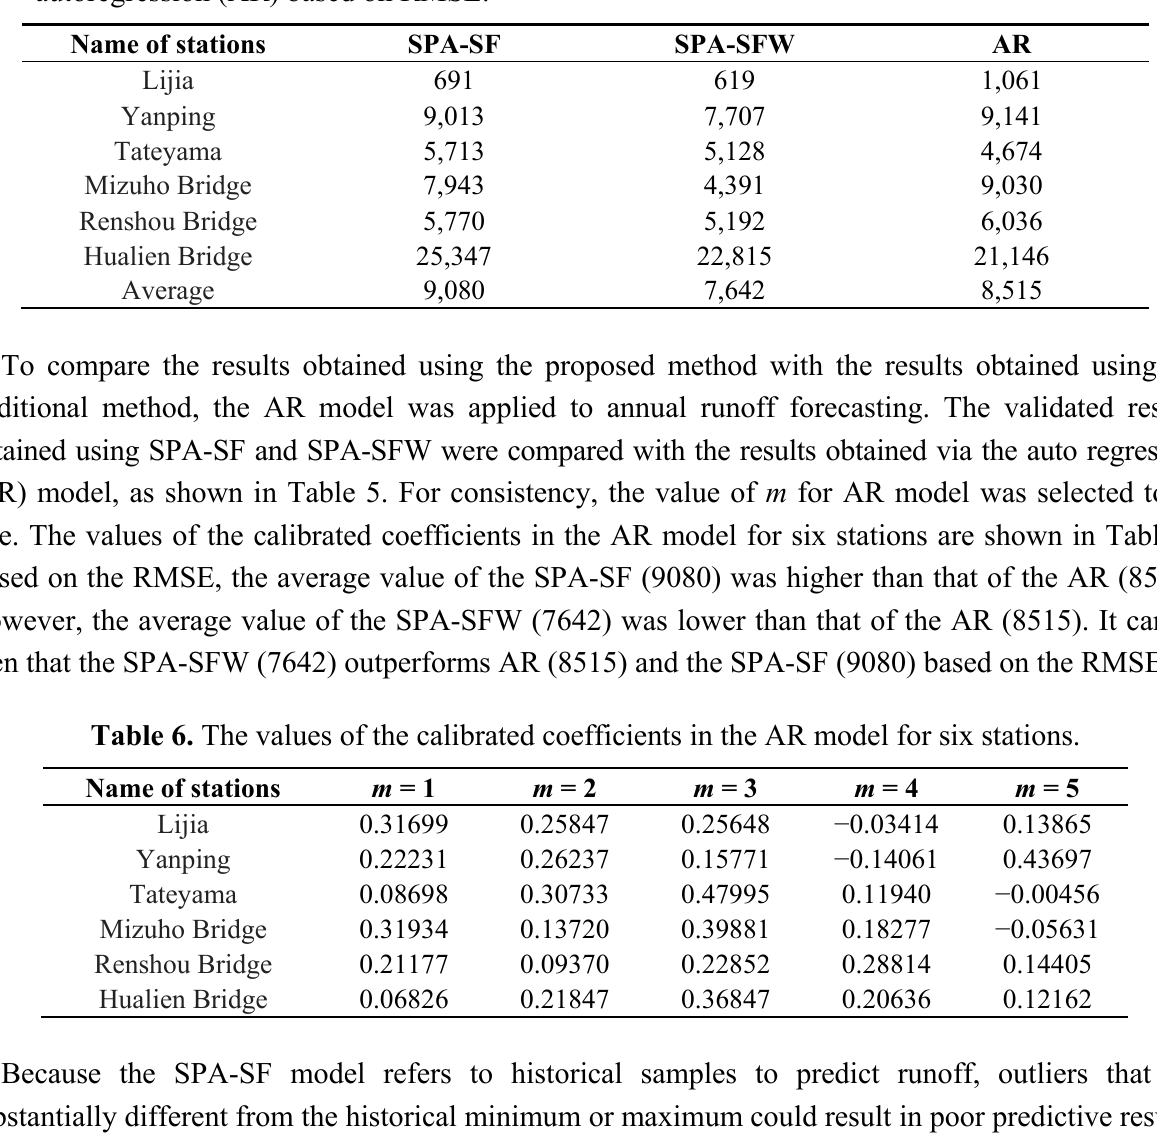
Table 5. The average forecasting results obtained using SPA-SF, SPA-SFW and autoregression (AR) based on RMSE.